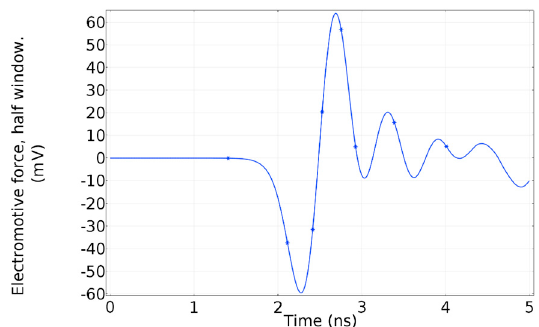
Figure 23. Electromotive force induced in half-window of a dielectric window with a radius of 50 mm.